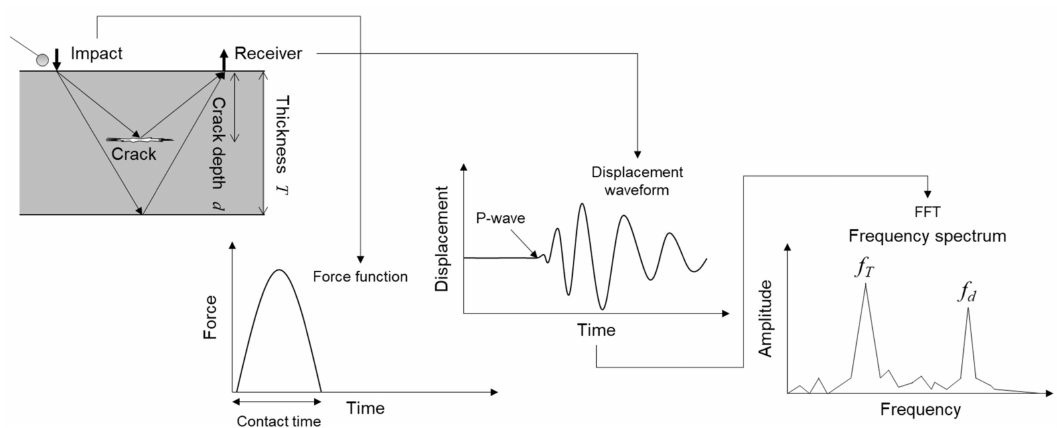
Figure 1. Schematic of impact-echo method applied to the testing interior concrete.